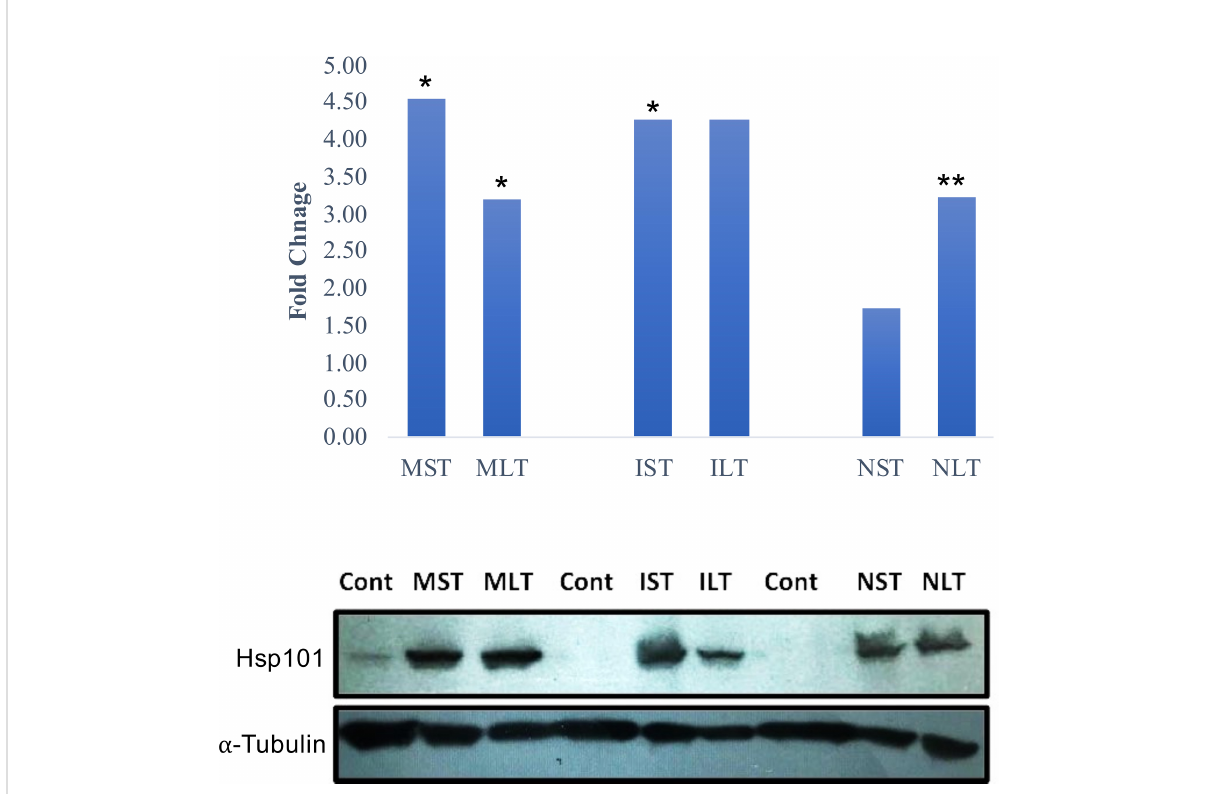
FIGURE 3 Hsp101 expression pro fi le in Moroberekan, IR64 and N22 rice types post short-term (ST) and long-term (LT) heat stress conditions. The upper panel shows Hsp101 protein expression found in proteome study with signi fi cance (*- p value<0.05; **- p value< 0.01). The lower panel shows western blotting for Hsp101 in the anther samples of Moroberekan, IR64 and N22 rice types. Alpha-Tubulin was used as a loading control for the blot to normalize the protein levels detected across the gel. ST, Short term heat stress; LT, Long-term heat stress; MC, Moroberekan control; MST, Moroberekan ST_HS; MLT, Moroberekan LT_HS, IC, IR64 control; IST, IR64 ST_HS; ILT, IR64 LT_HS, NC, N22 control; NST, N22 ST_HS; NLT, N22